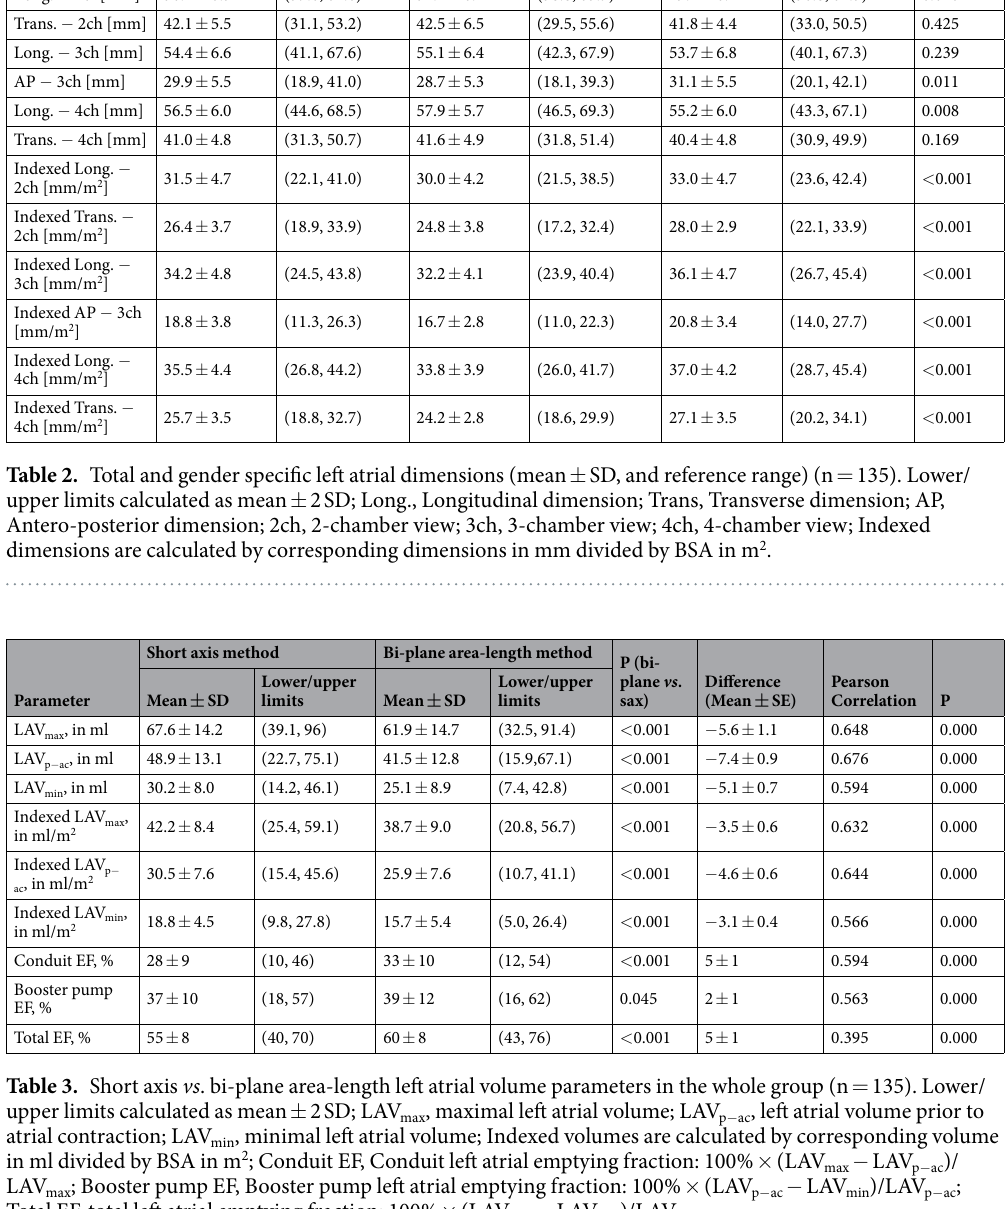
Table 3. Short axis vs . bi-plane area-length left atrial volume parameters in the whole group (n = 135). Lower/ upper limits calculated as mean ± 2 SD; LAV max , maximal left atrial volume; LAV p − ac , left atrial volume prior to atrial contraction; LAV min , minimal left atrial volume; Indexed volumes are calculated by corresponding volume in ml divided by BSA in m 2 ; Conduit EF, Conduit left atrial emptying fraction: 100% × (LAV max − LAV p − ac )/ LAV max ; Booster pump EF, Booster pump left atrial emptying fraction: 100% × (LAV p − ac − LAV min )/LAV p − ac ; Total EF, total left atrial emptying fraction: 100% × (LAV max − LAV min )/LAV max